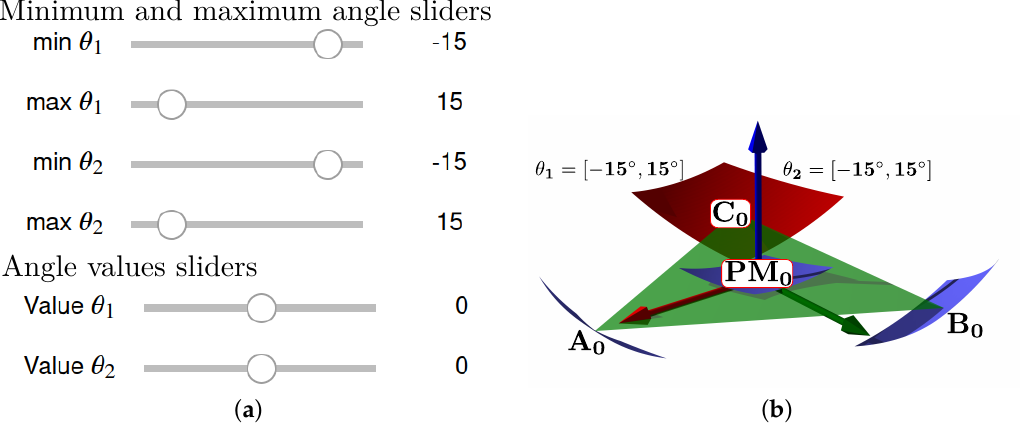
Figure 29. Interactive simulation example: ( a ) sliders, ( b ) rendering.